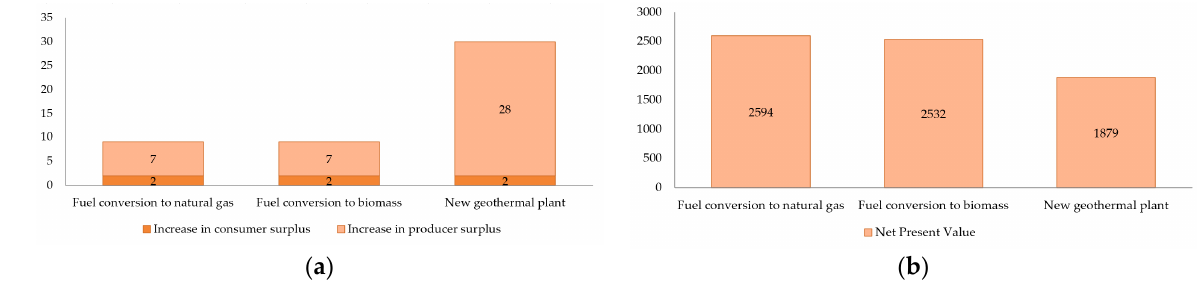
Figure 5. ( a ) Changes in socio-economic welfare in Slovakia compared to the reference scenario (million euros per year); ( b ) NPV2030 of different alternative projects 2030–2059 (million euros).